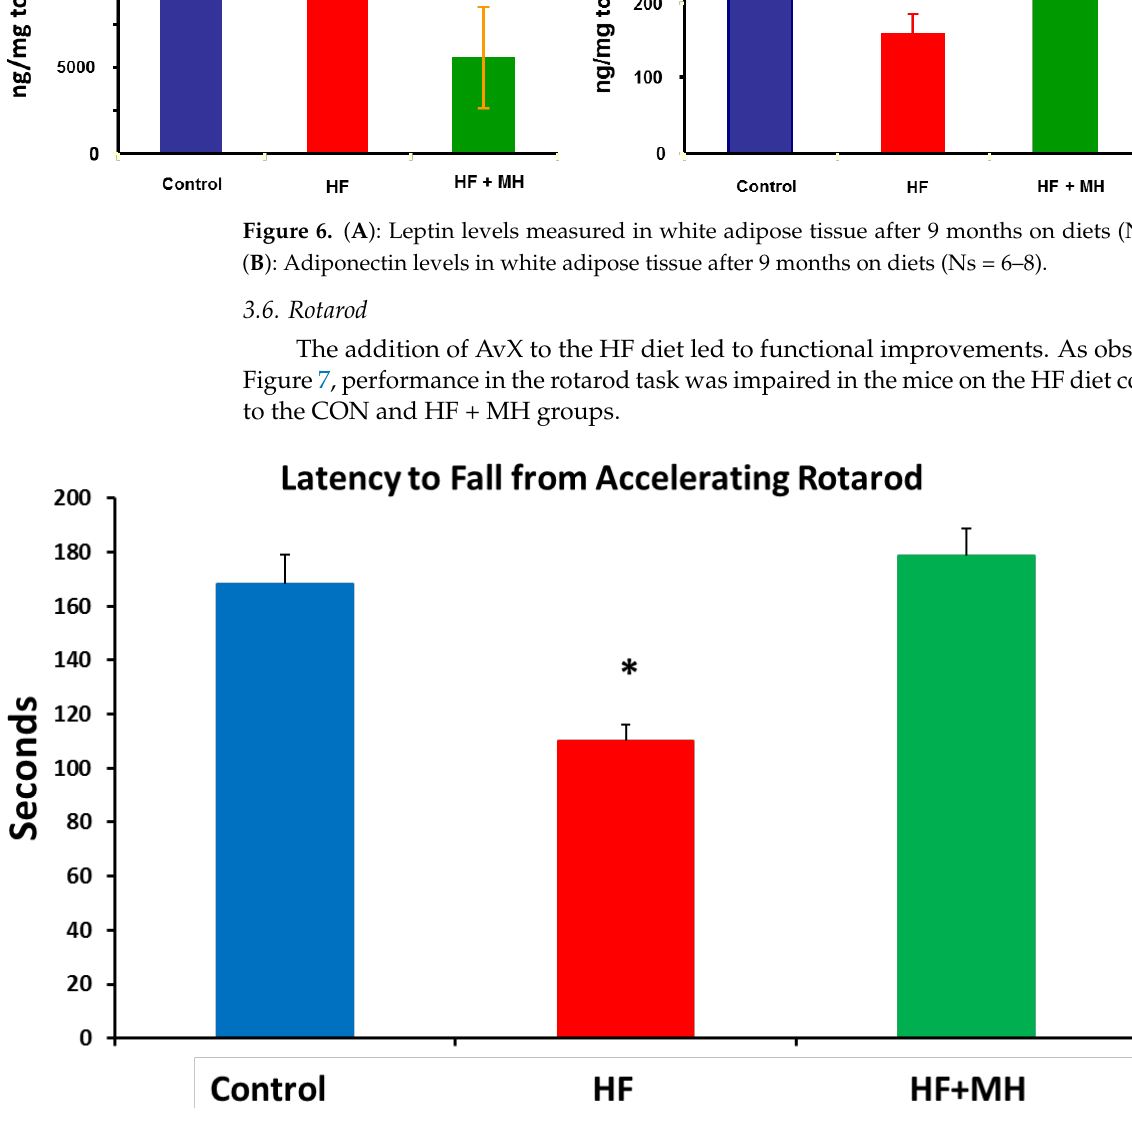
Figure 7. Comparison of diets effects on latency to fall from accelerating rotarod. (Ns = 15–16). * = p < 0.01 compared to controls.